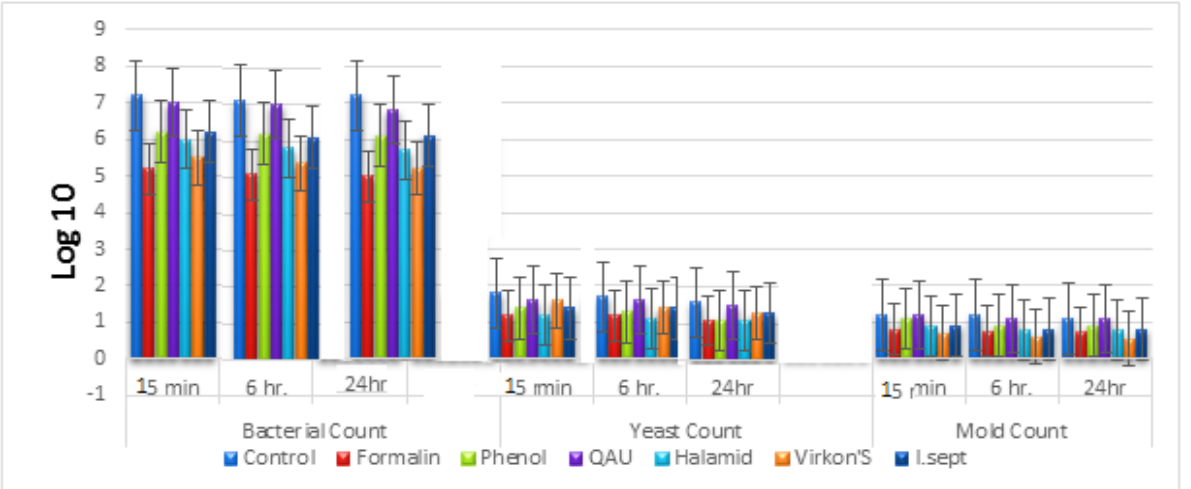
Fig. 1: The effect of low application level and contact time on total aerobic bacteria, yeast, and